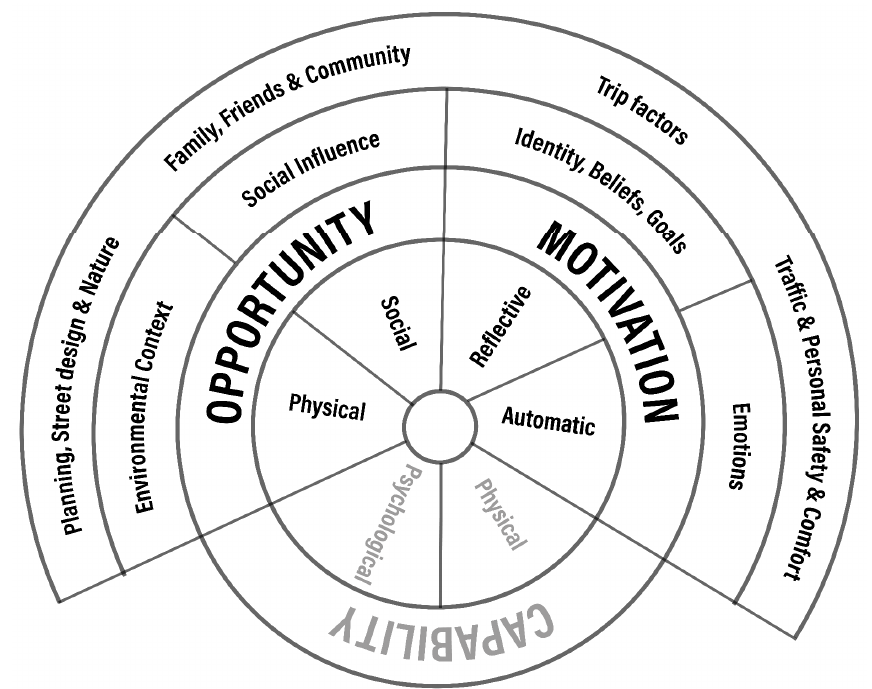
Figure 4. Theoretical domains explored through COM-B (adapted from [55,68]).